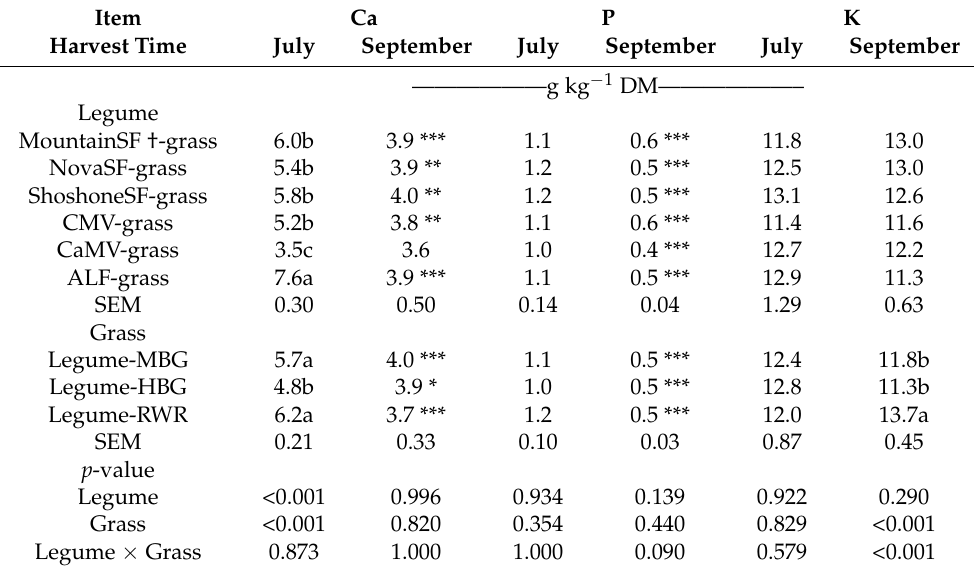
Table 7. Mineral composition of legume-grass binary mixtures at July and September harvest at Swift Current, Saskatchewan,